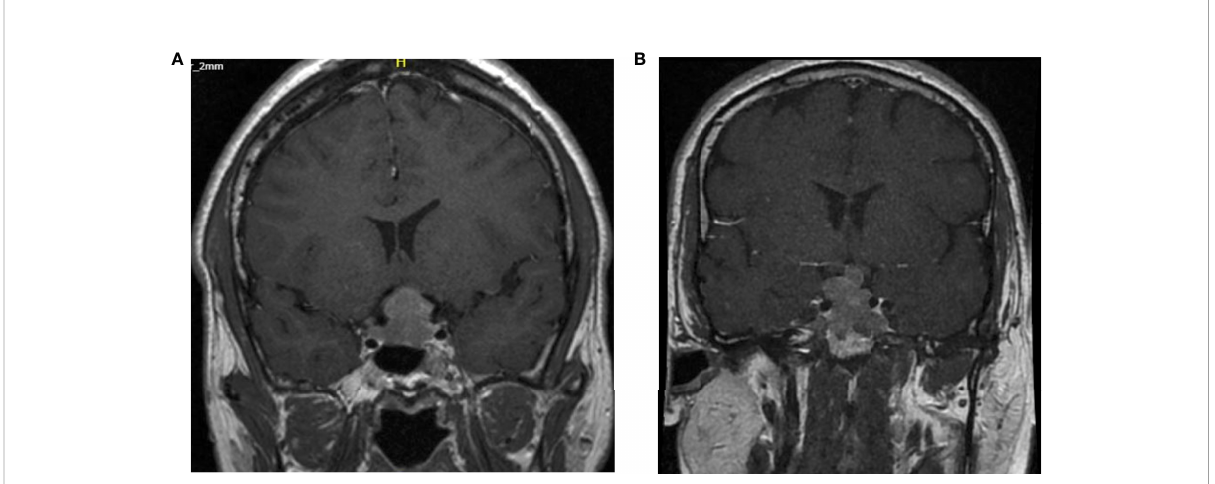
FIGURE 1 Cerebral MRI T1 weighted images with gadolinium at diagnosis of case 2 and case 5. (A) Knosp grade 4 classi fi cation of the second patient. (B) Knosp grade 3B classi fi cation of the 5 th